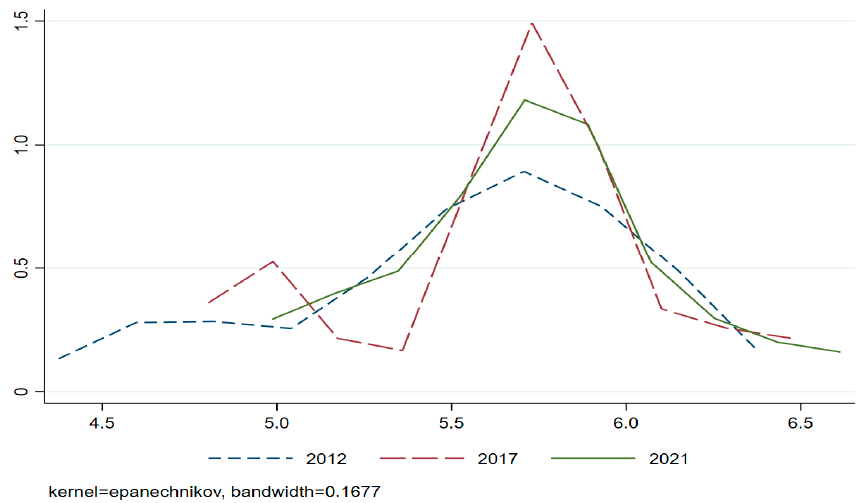
Figure 1. Kernel density map of the international competitiveness of wood-based paper products in the countries observed.